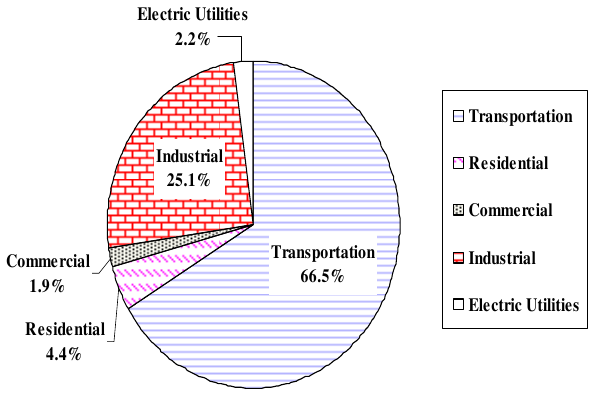
Figure 1: Distribution of petroleum consumption by end- use sector, 2002